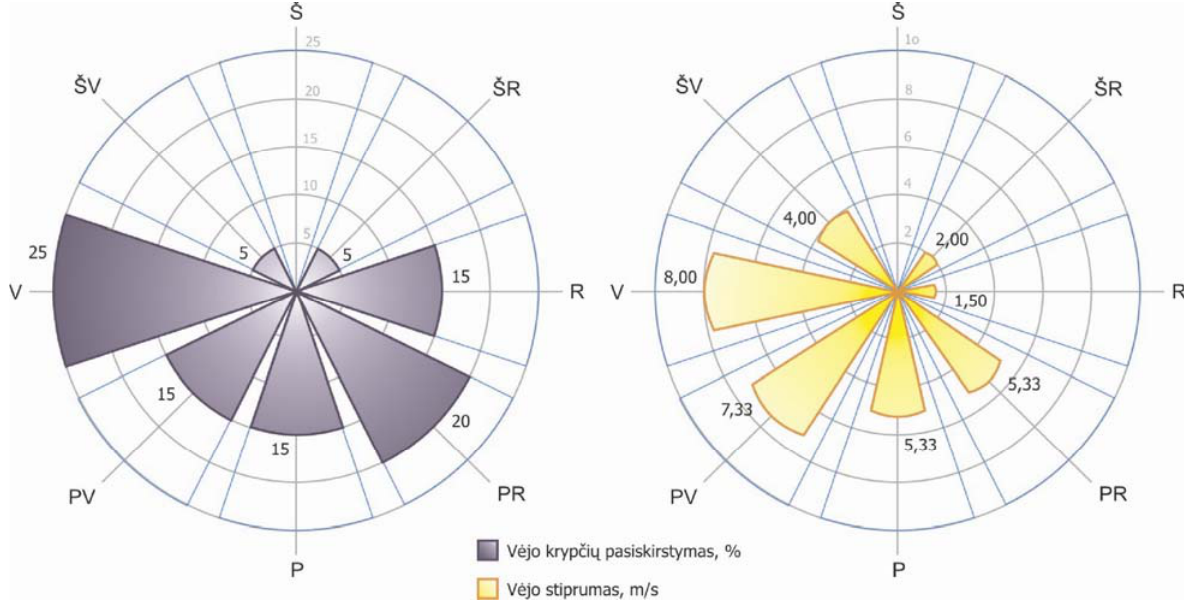
Fig 3. Dominant wind speed and direction during